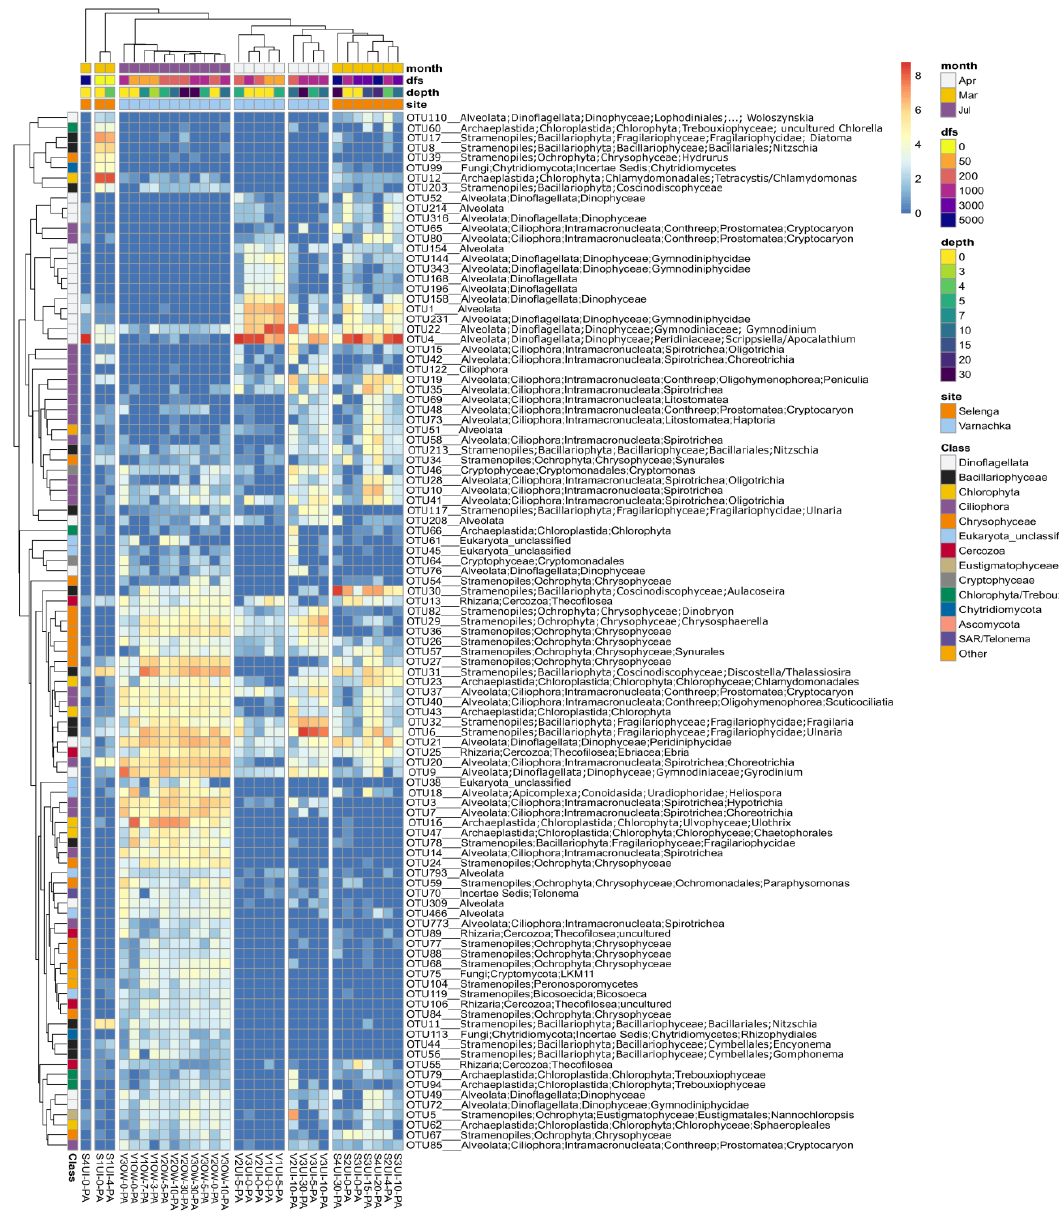
Figure 5. Hierarchical clustering of log2(x + 1)-transformed microeukaryotic OTU counts. Rows— OTUs; columns—samples. Clustering was performed on a matrix of Bray-Curtis dissimilarity distances. The color-coded annotation of samples is drawn in the upper part of the heatmap; dfs—distance from the shore.